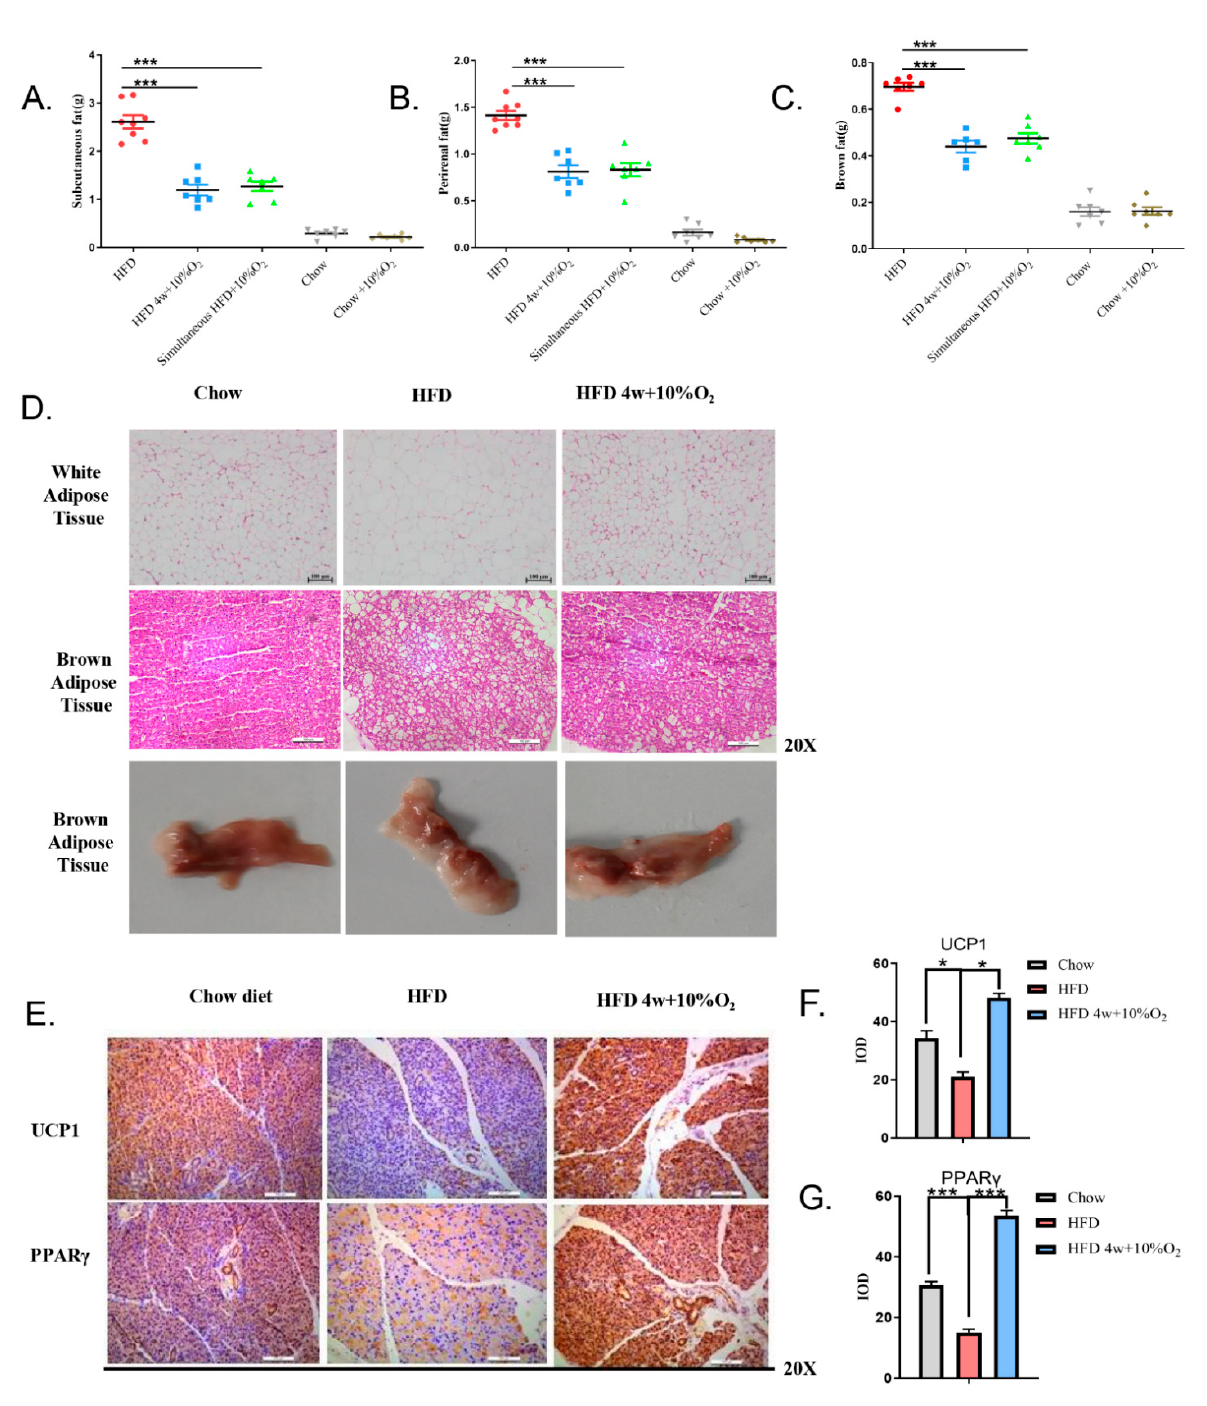
Figure 2. Hypoxia reduces the fat content of mice and promotes the expression of thermogenic genes in brown fat. ( A – C ) Subcutaneous fat, perirenal fat, and brown fat were isolated and weighed. Statistical analysis was performed by Student’s t -test (mean ± SEM, n = 8,) *** p < 0.005. ( D ) White fat and brown fat were examined by H&E staining at (20 × ) and representative images of gross brown fat are shown. ( E – G ) Brown fat was immuno-stained with UCP1 and PPAR γ antibodies, respectively. The stained slides were quantified by ImageJ software and the significance was tested by Student's t -test (mean ± SEM, n = 3). * p < 0.05, *** p < 0.005.